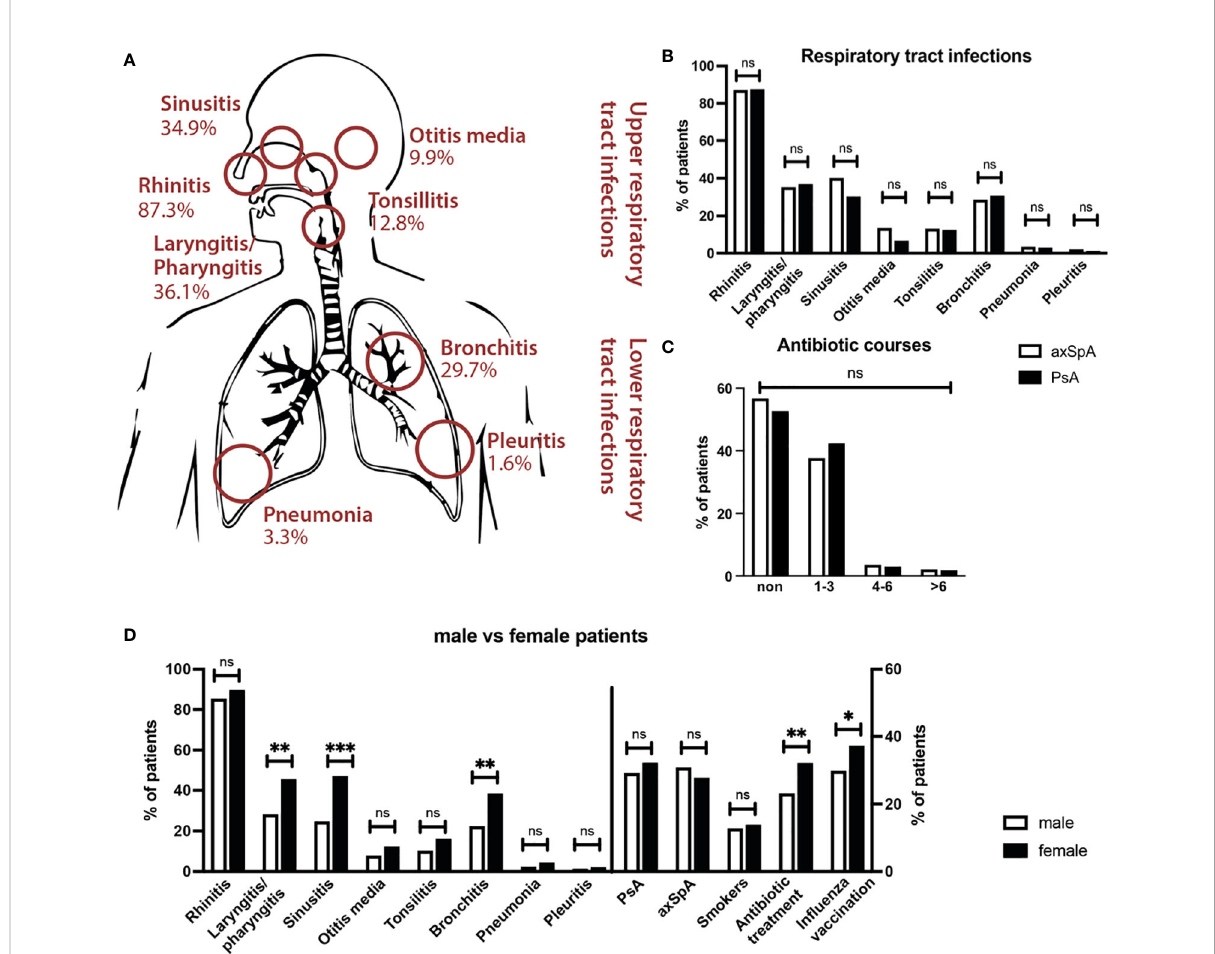
FIGURE 1 Frequency of respiratory tract infections in SpA patients. (A) Frequencies of upper and lower respiratory tract infections in total cohort. Rhinitis, laryngitis/pharyngitis and sinusitis were the most common infections. (B) Comparison of frequency of reported RTIs in axSpA (white bars) and PsA (black bars) shows no signi fi cant differences. (C) No signi fi cant differences in antibiotic therapy between axSpA (white) and PsA (black) patients. (D) Differences in infection frequency between male (white bars) and female patients (black bars). Female patients reported signi fi cantly more laryngitis/pharyngitis, sinusitis and bronchitis, and more often received antibiotic treatment *** p<0.001; ** p<0.01; * <0.05; ns not signi fi